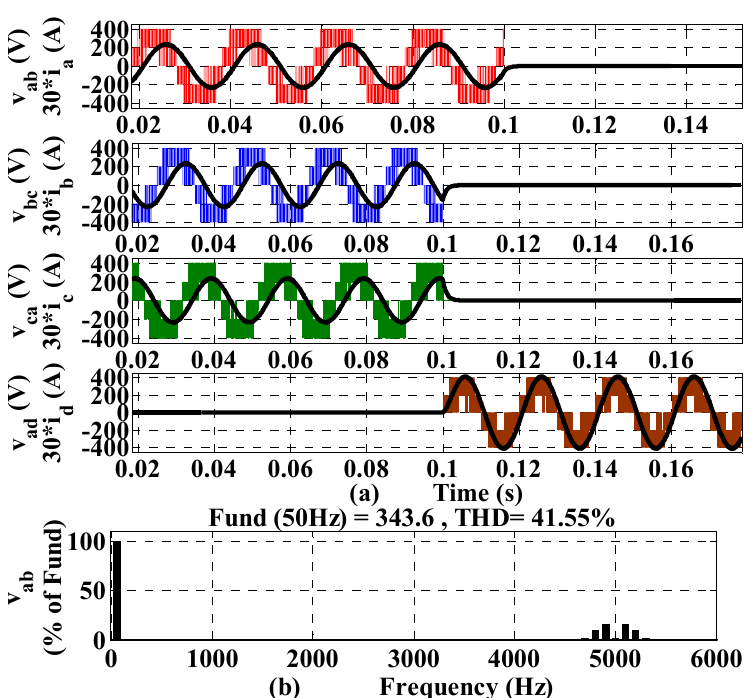
Figure 8. ( a ) Simulated voltage and current waveforms for either operation of the two inverters for common frequency of 50 Hz and modulation indices of 1.1547 and 1, ( b ) corresponding FFT profile of the line voltage waveform, v ab , for this point of operation.